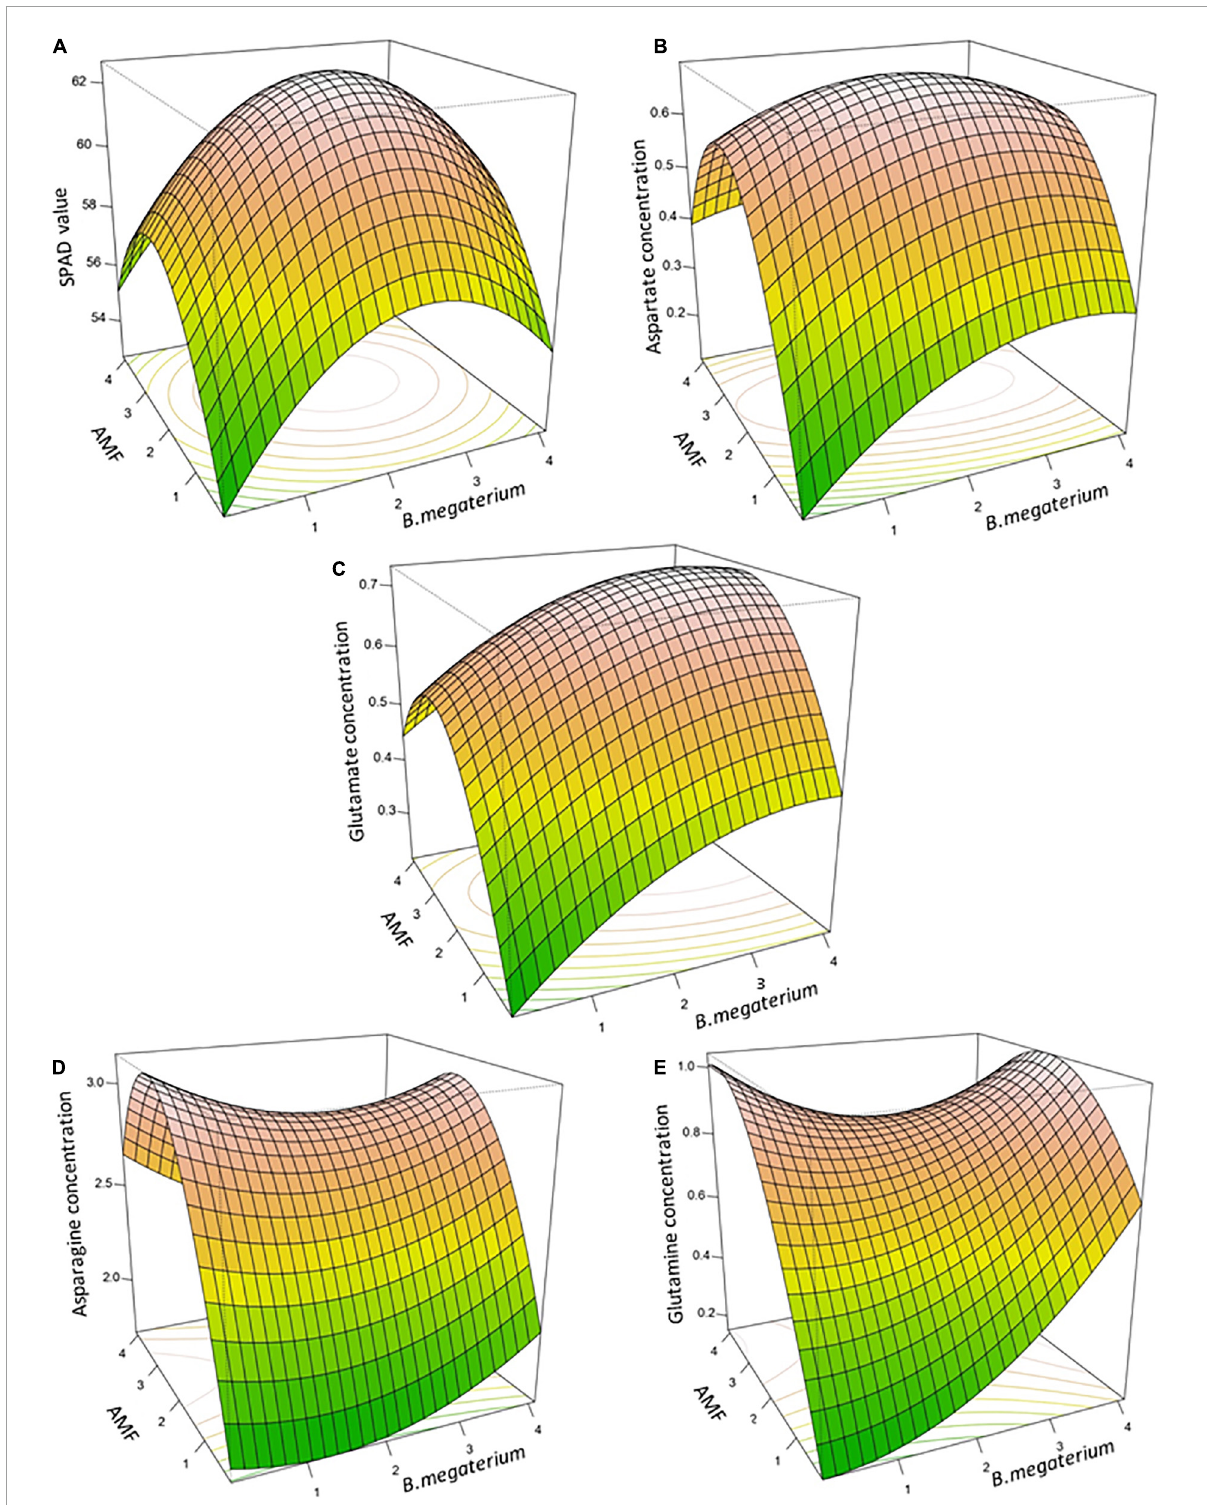
FIGURE2 The three-dimensional response surface plots for interactive effects of B. megaterium and AMF co-inoculation on SPAD value (A) , aspartate concentration (B) , glutamate concentration (C) , asparagine concentration (D) , and glutamine concentration (E) in maize.